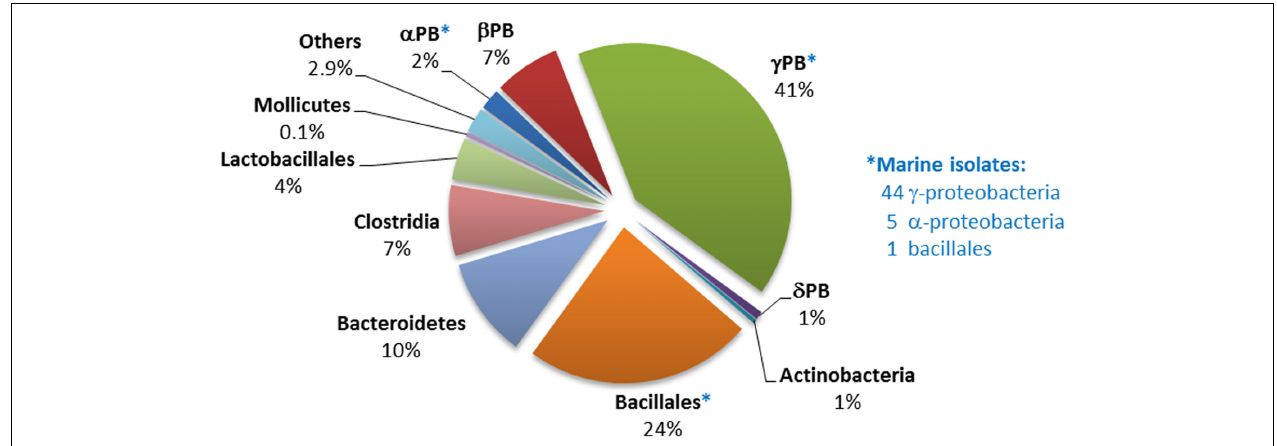
FIGURE 4 | Distribution of phnX homologs within sequenced bacterial genomes. The numbers and affiliations of marine bacterial strains that contain